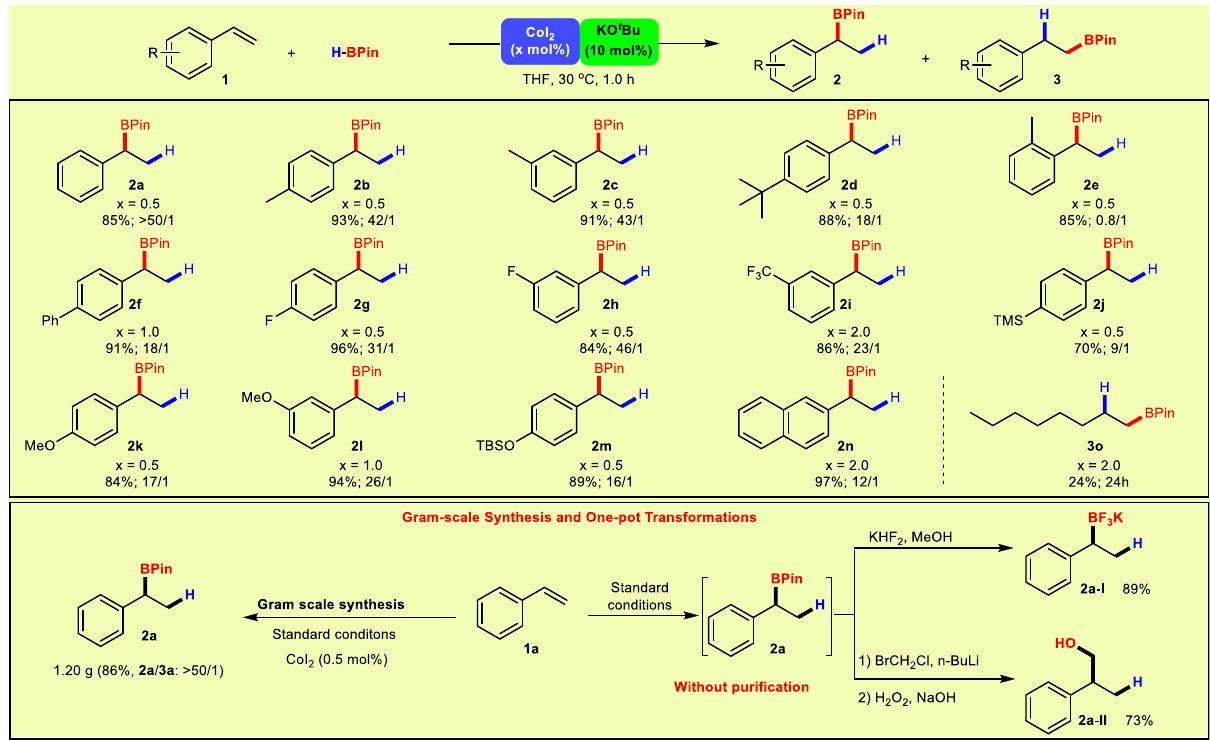
Fig. 3 CoI 2 /KO t Bu catalyzed Markovnikov hydroboration of vinylarenes. Reaction conditions: HBPin (1.2 mmol) was added to a mixture of CoI 2 (0.5 – 2.0 mol%), KO t Bu (0.1 mmol) and 1 (1.0 mmol) in 5 mL anhydrous THF, and the mixture was stirred at 30 °C for 1.0 h under N 2 . The yields are for isolated 2 and 3 . The ratio of 2 / 3 was determined by 1 H-NMR of the crude